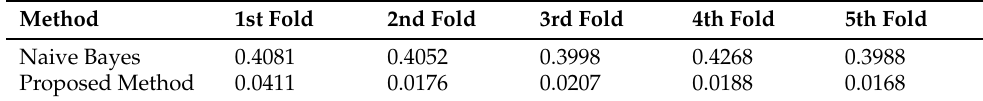
Table 5. Mean value of absolute errors of the proposed method and the Naive Bayes classifier. It can be considered that the proposed method outperforms the Naive Bayes